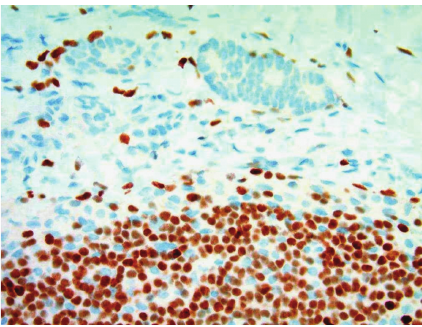
Figure 5: Photomicrograph of glandular epithelial rest in postneo- adjuvant ipsilateral axillary sentinel lymph node (GATA3 immuno- histochemical study, original magnification 400x).